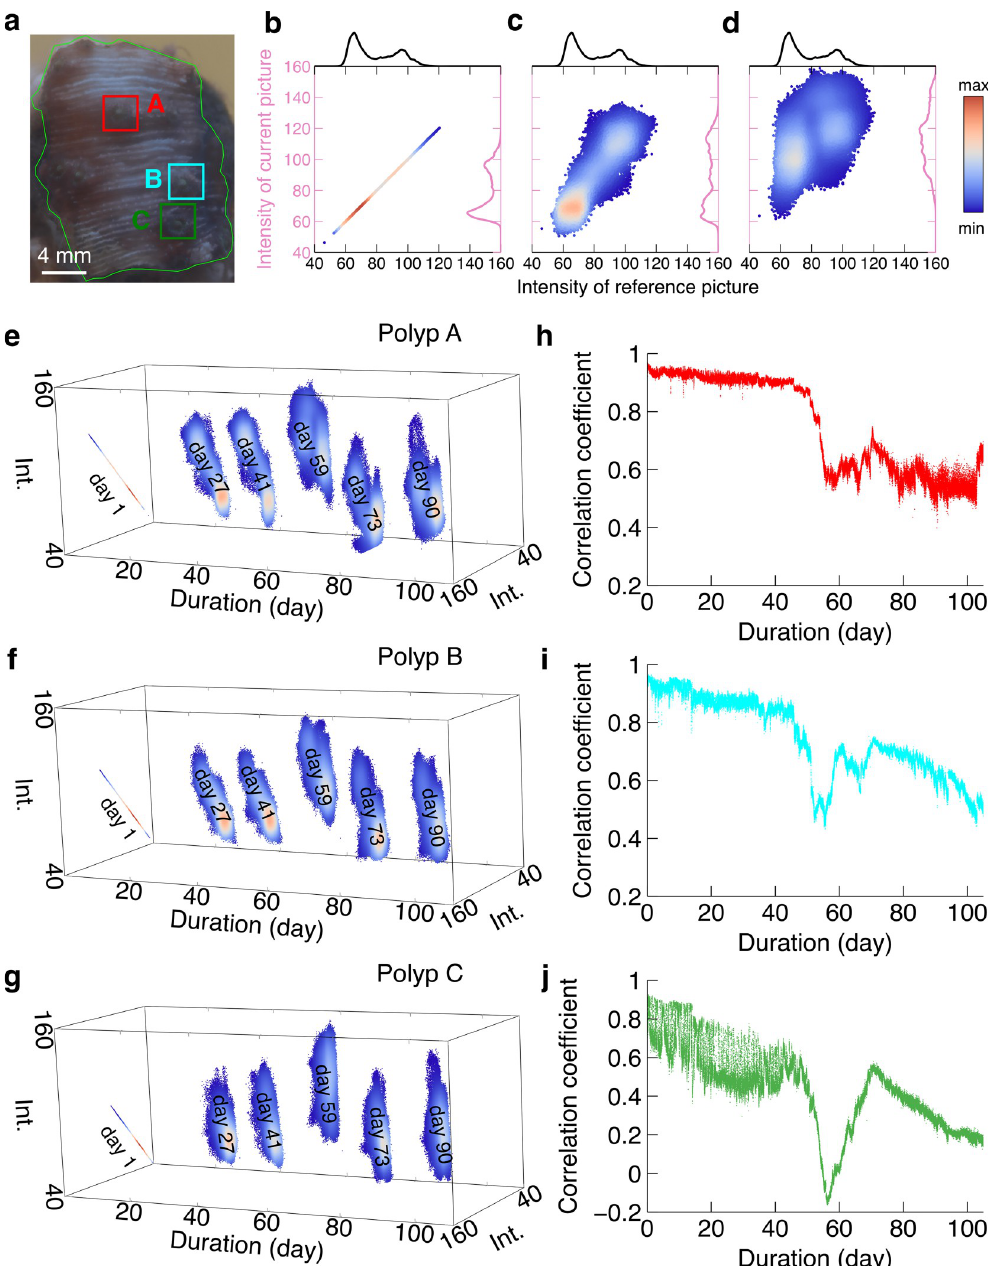
Fig 2. Intensity plot and Pearson correlation coefficient. (a). The image of Montipora capricornis on day 1 with color correction. Polyps A, B and C are shown in red, cyan and green. The intensity plot of the green channel of polyp A on (b) day 1. (c) day 27, and (d) day 59. The histograms of the reference picture and current picture are shown on the top in black and on the right in magenta. Intensity plots of green channels of polyp A sliced on days 1, 27, 41, 59, 73 and 90 are shown for (e) polyp A, (f) polyp B, and (g) polyp C. The density is encoded with color. Pearson correlation coefficients as a function of time when taking the first picture as the reference for (h) polyp A, (i) polyp B, and (j) polyp C. around day 50 from the raw images (see S1 Movie). Finally, because the macroalgae grow on the surface of corals, their morphology will be covered by the macroalgae. However, the simi- larity will not change significantly so that the Pearson correlation coefficient will converge.